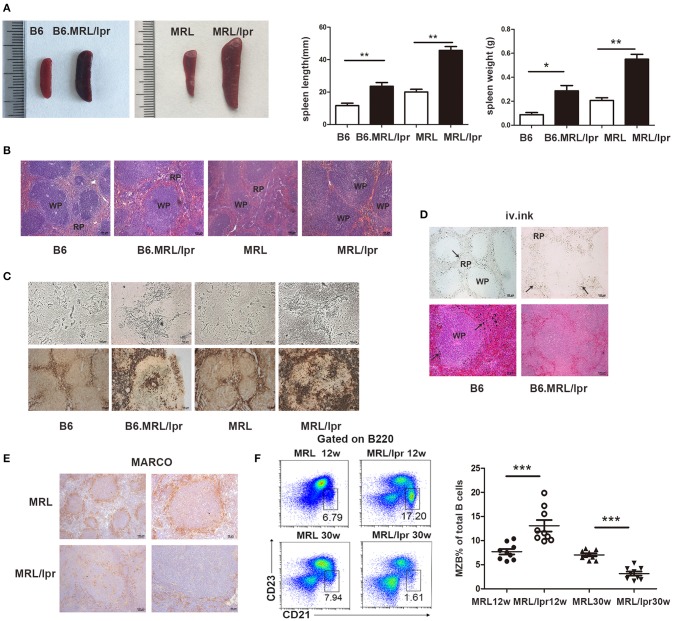
MRL/lpr mice spontaneously developed splenomegaly. (A) The size and weight of the spleens of 30-week-old B6.MRL/lpr, 26-week-old MRL/lpr mice and C57BL/6, MRL mice of the same age. (B) The representative histopathology of the spleens of 30-week-old B6.MRL/lpr, 26-week-old MRL/lpr mice, and C57BL/6, MRL mice of the same age. (C) Silver impregnation (upper part) and positive acid phosphatase reaction (under part) in the spleens of B6 (30 weeks), B6.MRL/lpr (30 weeks), MRL (26 weeks) and MRL/lpr mice (26 weeks). (D) Ink injection evaluation of the physiological function of the spleens of B6 mice (30 weeks) and B6.MRL/lpr mice (30 weeks). Carbon particles (arrow markers) distributed in the marginal zone of B6 mice and in the red pulp of B6.MRL/lpr mice. (E) MARCO expression in the spleens of MRL and MRL/lpr mice (30 weeks). (F) FACS analysis of the frequency of MZB cells (B220+CD21/35hiCD23lo) in the spleens of MRL/lpr (12 weeks and 30 weeks) and control MRL mice (12 weeks and 30 weeks). Data are representative of three experiments, n = 4–5 mice per group. WP, white pulp; RP, red pulp. *P < 0.05, **P < 0.01, ***P < 0.001.